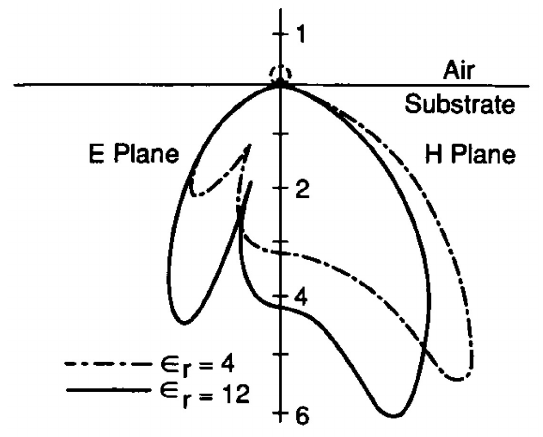
Figure 3. Radiation patterns of a resonant dipole on a semi-infinite dielectric substrate with (cid:101) r = 4 and (cid:101) r = 12